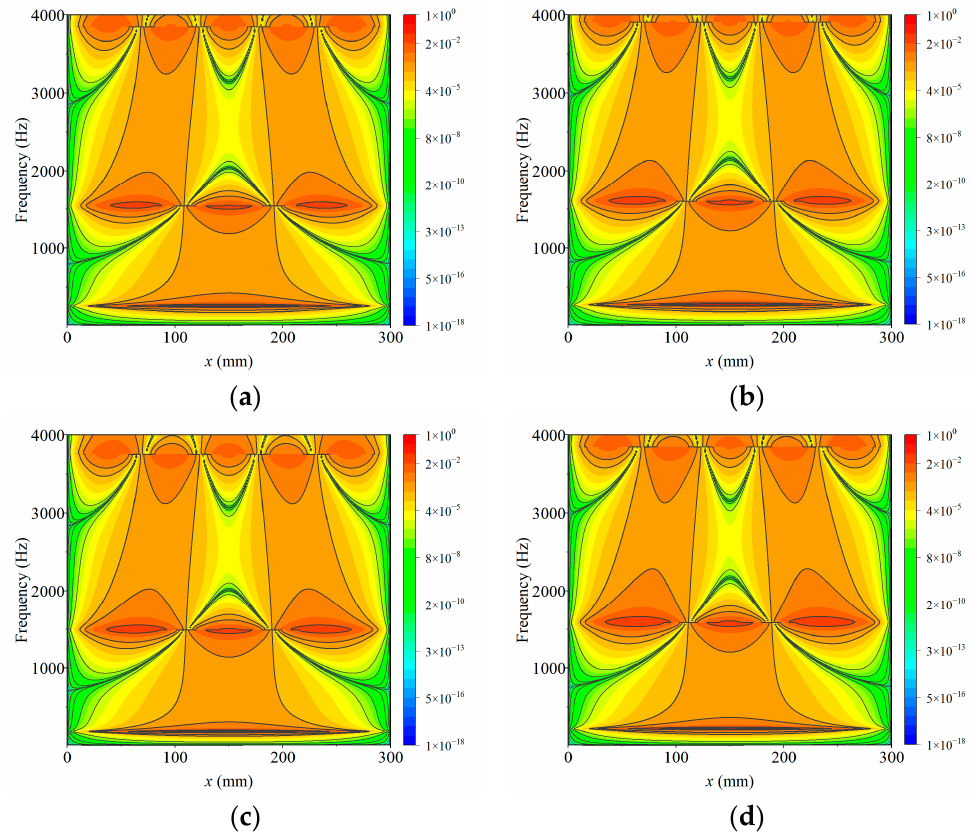
Figure 13. PSD contour of acceleration in the z-direction under di ff erent combined loads (g2/Hz): ( a ) case c 1; ( b ) case c 2; ( c ) case c 3; ( d ) case c 4. ( a ) case c 1; ( b ) case c 2; ( c ) case c 3; ( d ) case c